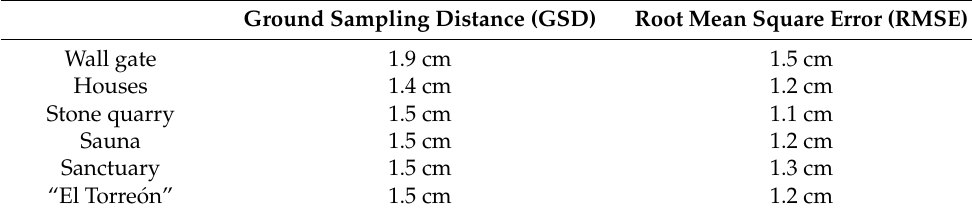
Table 3. Metric control and final accuracy of the different point